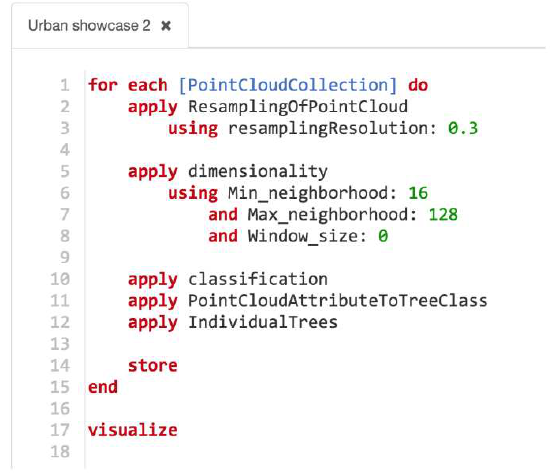
Figure 9. The workflow editor in the IQmulus main user interface can be used to edit processing workflows in a Domain-Specific Language (DSL)